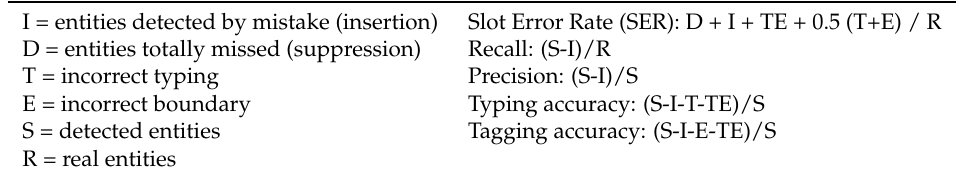
Table 1. The calculated